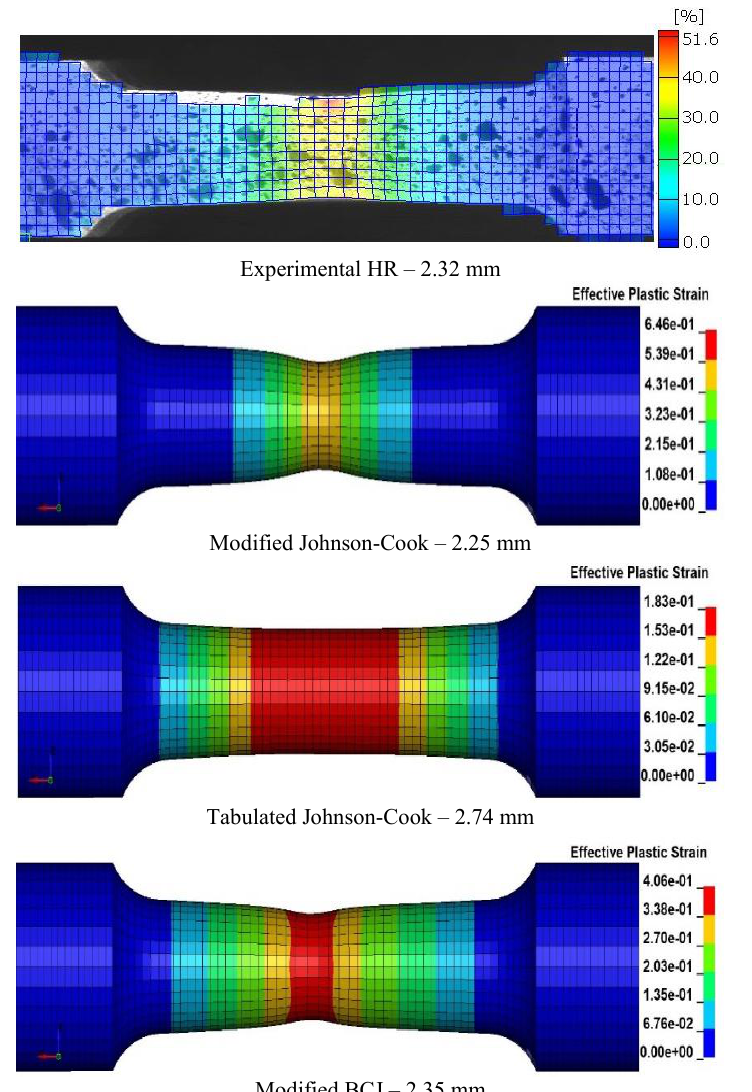
Fig. 6. Strain localization prediction using Modified Johnson-Cook, Tabulated Johnson-Cook, and Modified BCJ for the high-rate monotonic loading